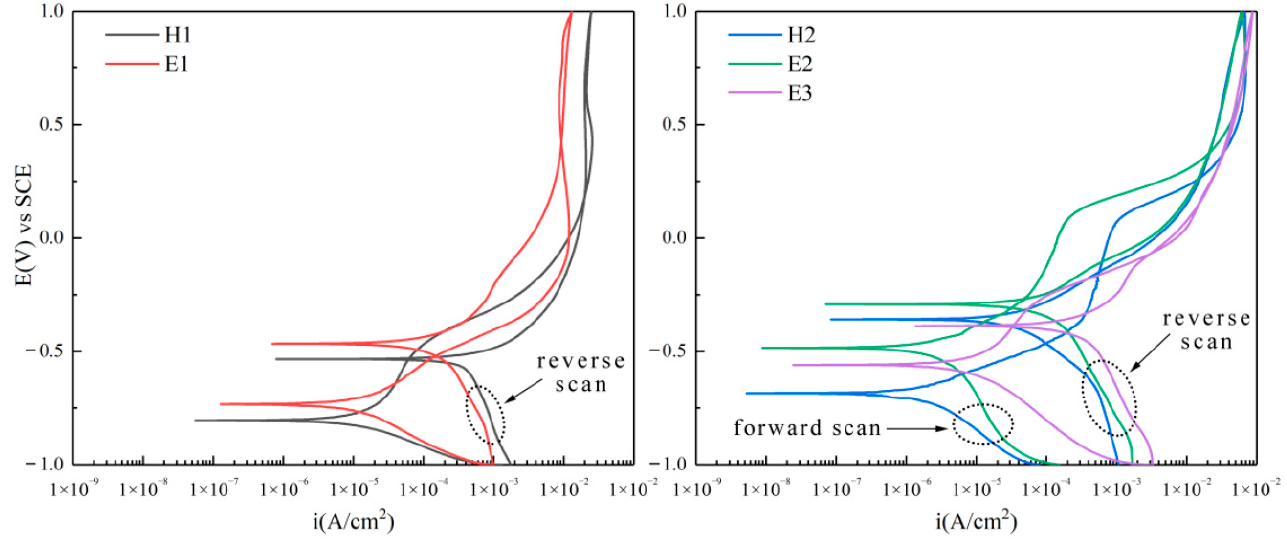
Figure 9. Potentiodynamic polarization curves.